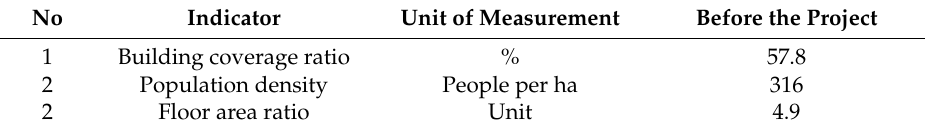
Table 7. Land-use e ffi ciency of the Compact city